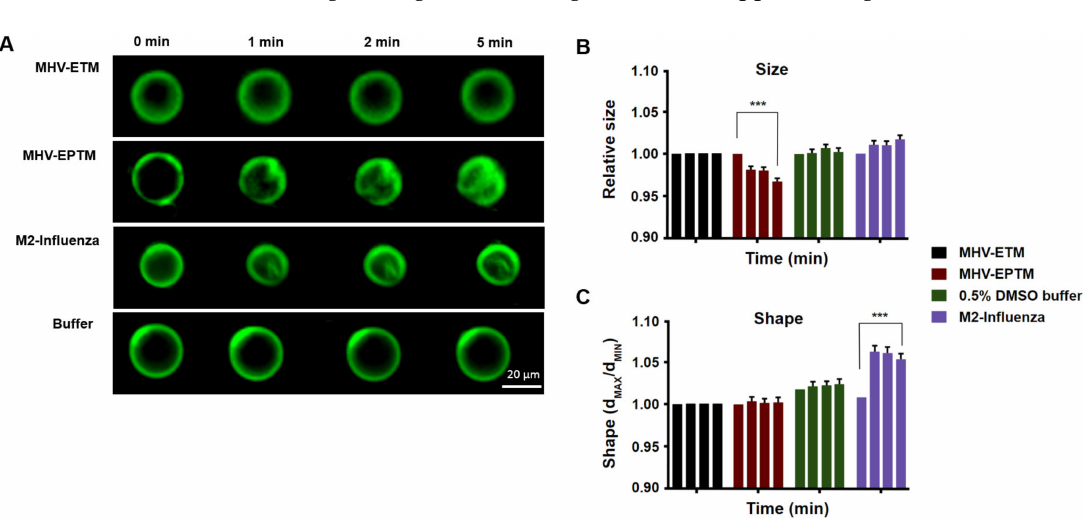
Figure 2. E ff ect of MHV E protein-derived peptides on size and shape of GUVs. ( A ) Fluorescent images of electroformed GUVs treated with peptides MHV-EPTM, MHV-ETM and M2-Infleunza and imaged at 0, 1, 2 and 5 min postaddition. ( B ) GUV relative size estimated by Ramanujan’s first approximation. Then standard deviation for both long and short measurements for a vesicle was also measured and averaged for each GUV for three separate experiments of 40 GUVs each. ( C ) GUV shape, measured as the ratio between the longest and shortest radii and averaged for each GUV for three separate experiments of 40 GUVs each. The scale bar indicates 20 µ m. Error bars shown are mean ± SEM. The stars *** indicate significance ( p ≤ 0.001; with respect to the corresponding bu ff er; Linear Mixed). Each coloured group of four columns represents the data for a single peptide test at each time